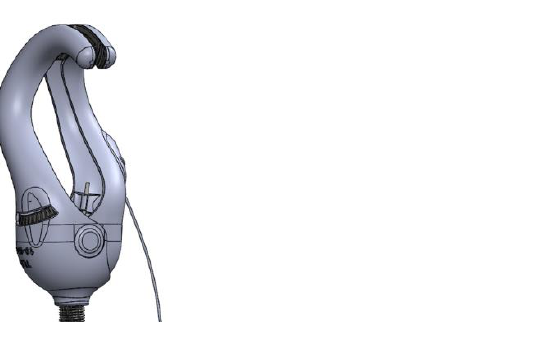
Figure 2. Conceptual design: gripper and hook with force regulation.